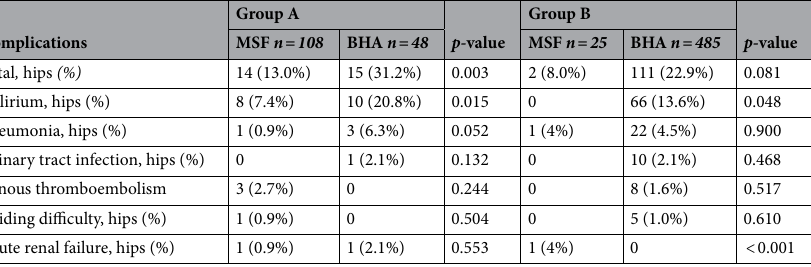
Table 4. Comparison of in-hospital systemic complications between patients with MSF and cementless BHA according to fracture type. MSF, multiple screw fixation; BHA, cementless bipolar hemiarthroplasty; n ,